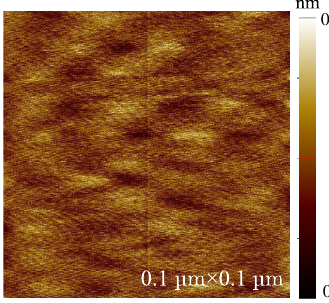
FIG. 6. Noncontact mode AFM scan image of the side surface of a quartz tip. Commercial AFM was employed to obtain the AFM image. We find that the root-mean-square roughness of the quartz surface is about 0.1 nm.